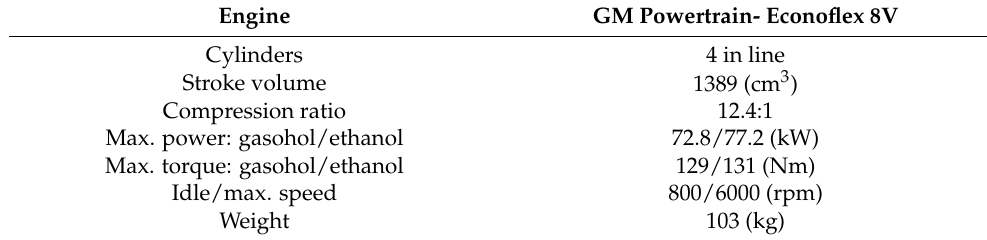
Table 1. Engine specifications